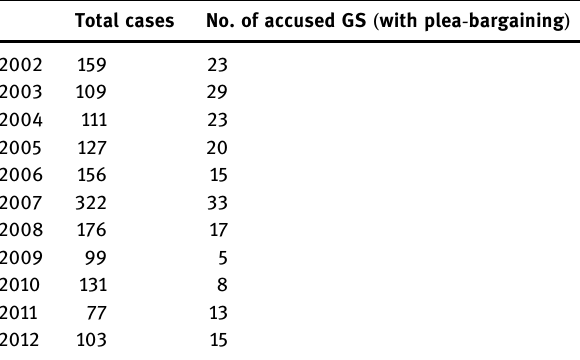
Table 3: National Accountability Bureau annual number of cases Total